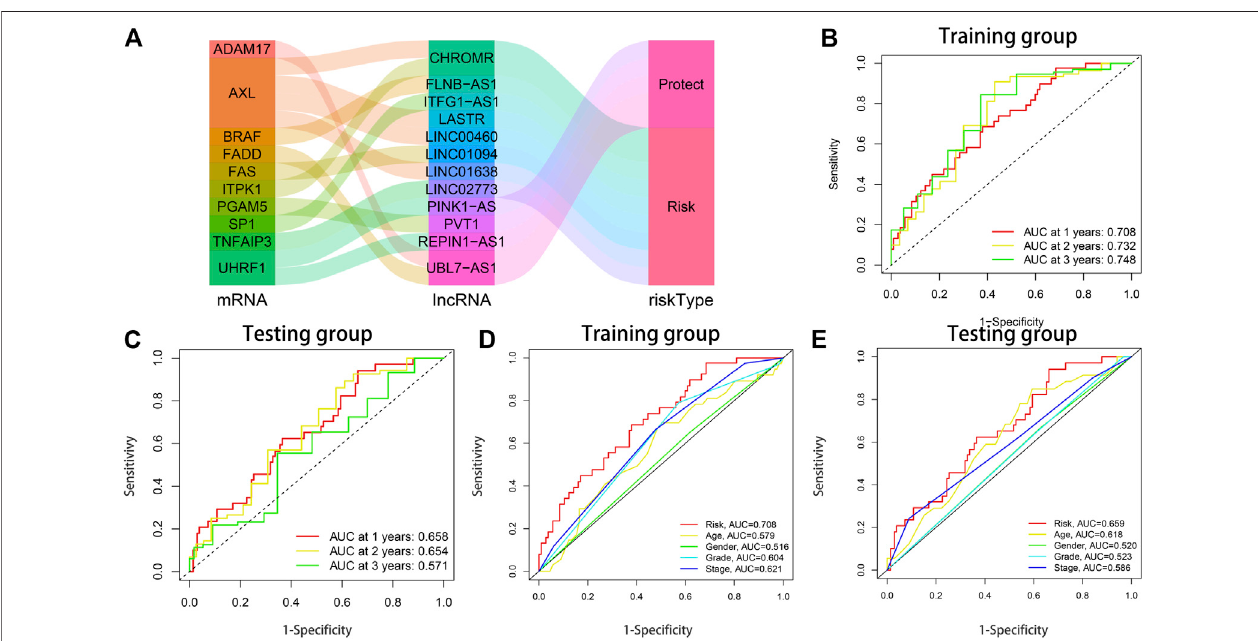
FIGURE 4 | The prognostic performance of the 12-lncRNAs signature in the training and testing sets. (A) The Sankey diagram shows the connection degree between the necroptosis-related lncRNAs and necroptosis-associated genes. (B) AUC of time-dependent ROC curves at 1-, 2-, and 3-years OS in the training set. (C) AUC of time-dependent ROC curves at 1-, 2-, and 3-years OS in the testing set. (D) ROC curve analysis of clinicopathological parameters and risk score in the training set. (E) ROC curve analysis of clinicopathological parameters and risk score in the testing set.